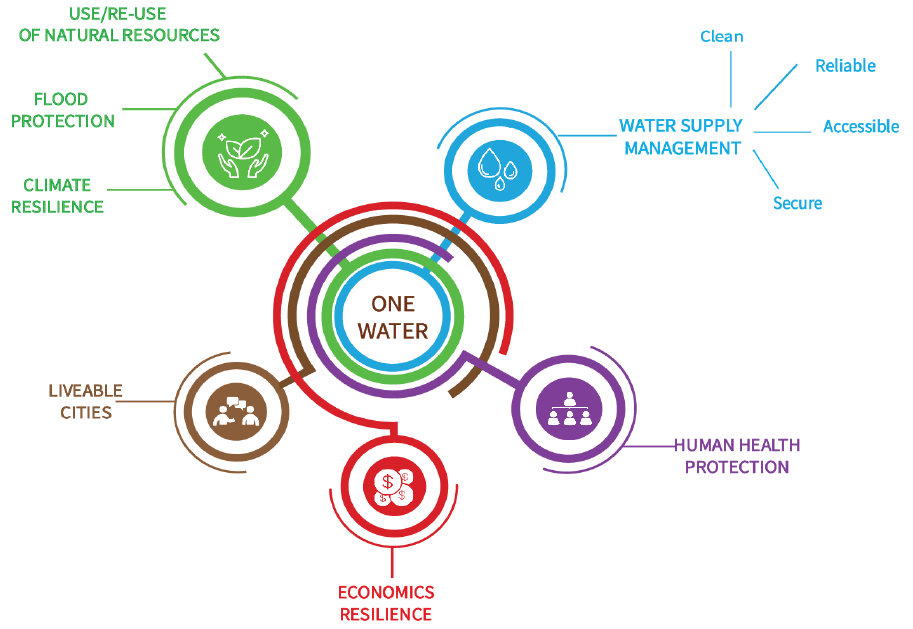
Figure 5. One Water—IWCM interpretation in the US.